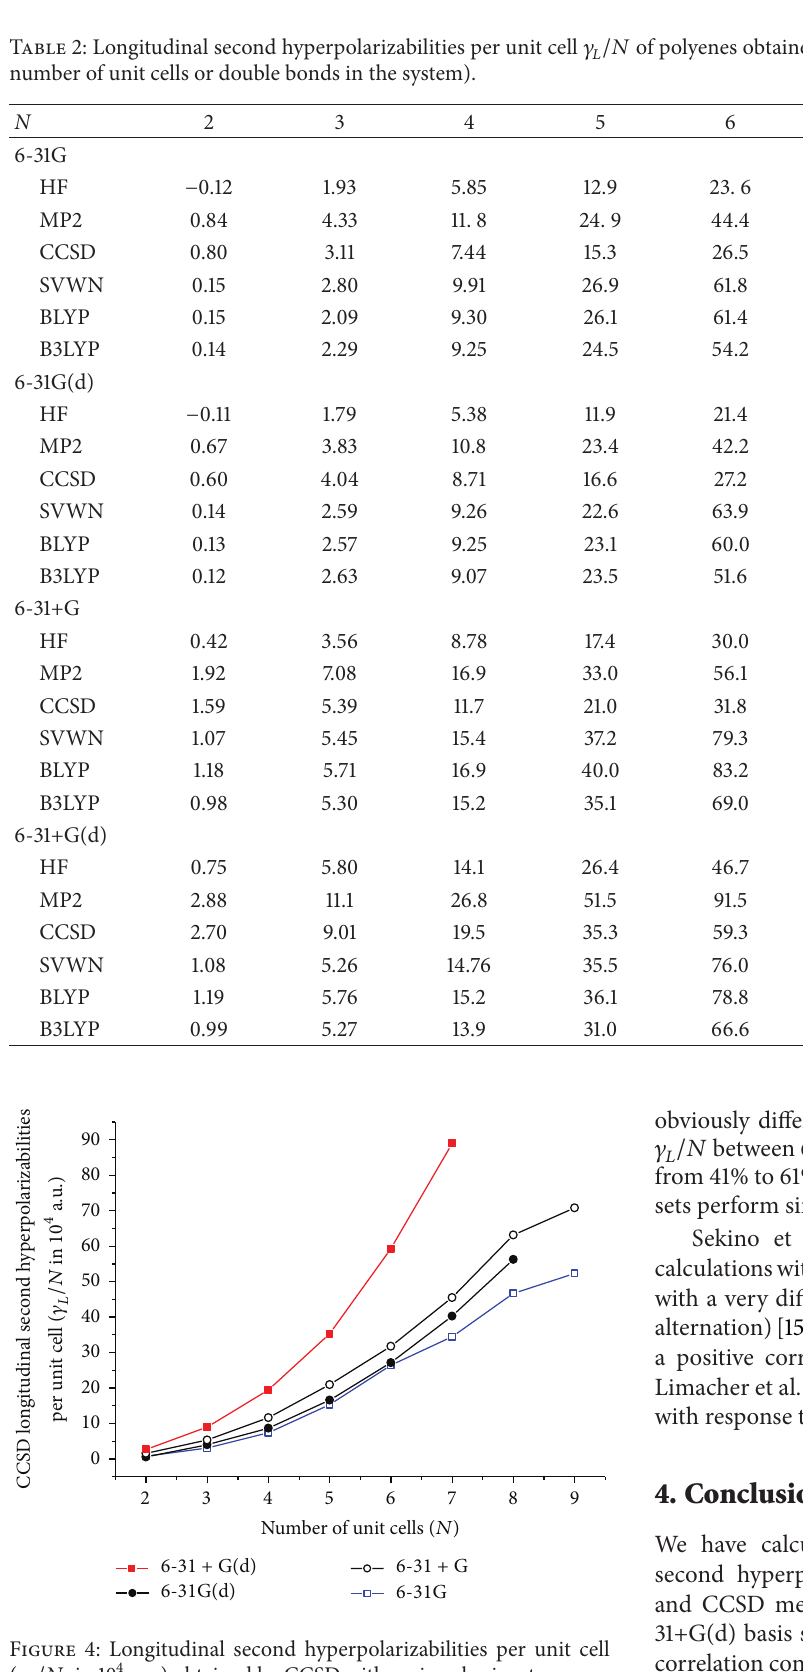
Table 2: Longitudinal second hyperpolarizabilities per unit cell 𝛾 𝐿 /𝑁 of polyenes obtained by various chemical models (in 10 4 a.u., N is the number of unit cells or double bonds in the system).